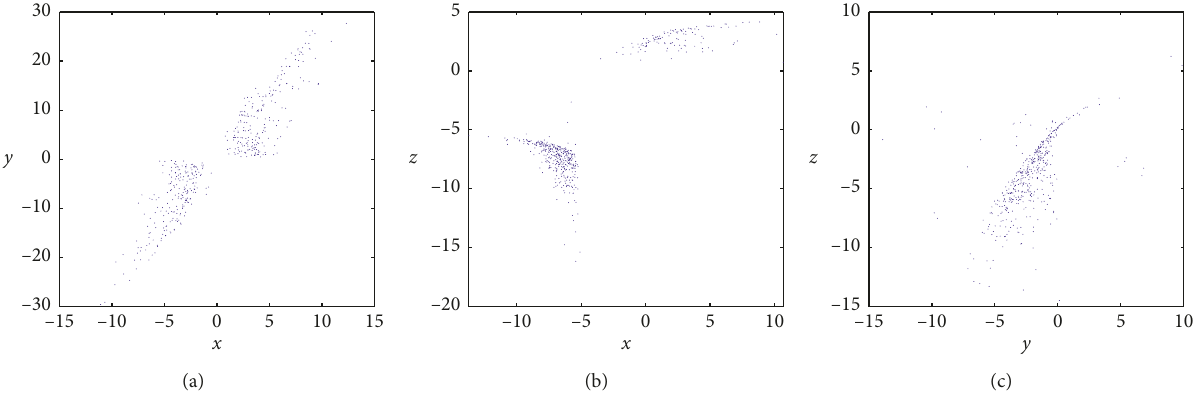
Figure 5: Poincare map of system (2) with parameters a � 1: (a) projection on x − y plane with z � 0, (b) projection on x − z plane with y � 0, and (c) projection on y − z plane with w � 0.